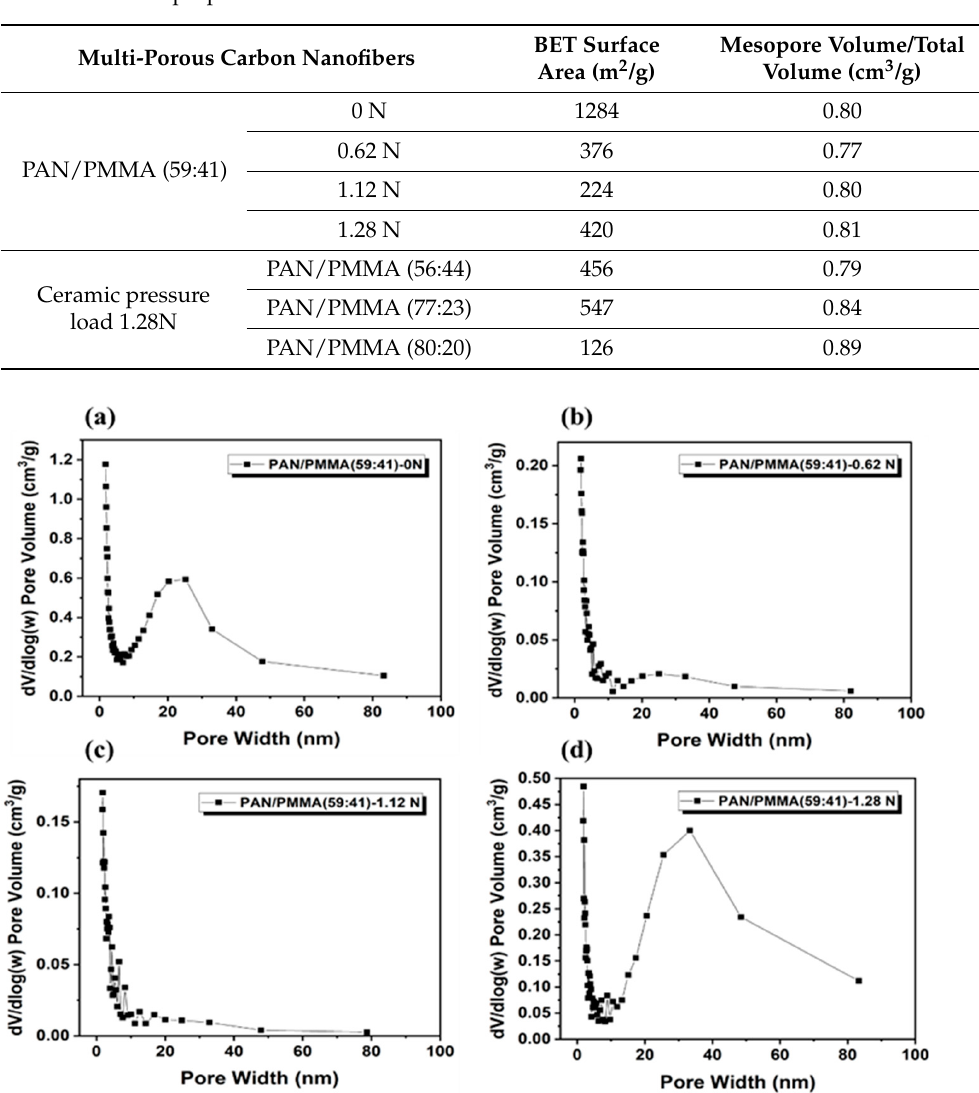
Table 1. Textural properties of obtained carbon nanofiber materials.